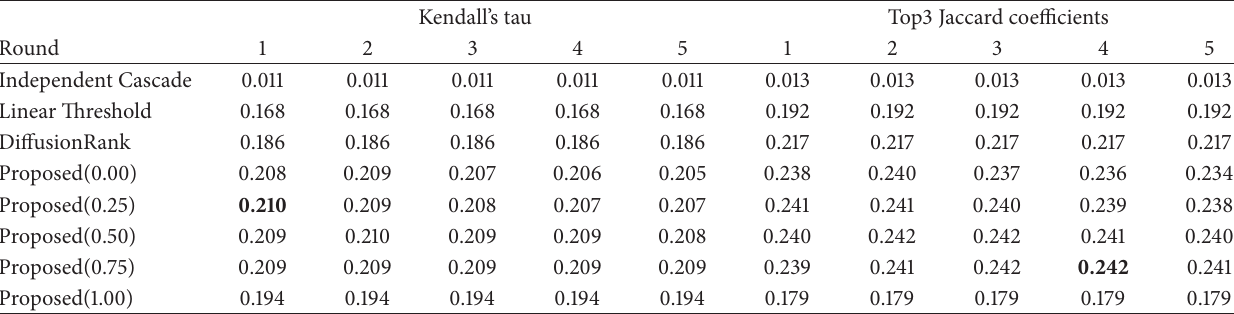
Table 3: Consider the result after 𝑘 × 𝑅 rounds for each model, and compare it with the ground truth of year 1996 + 𝑘 . The table shows the average of the similarity scores for 1997, 1998, and